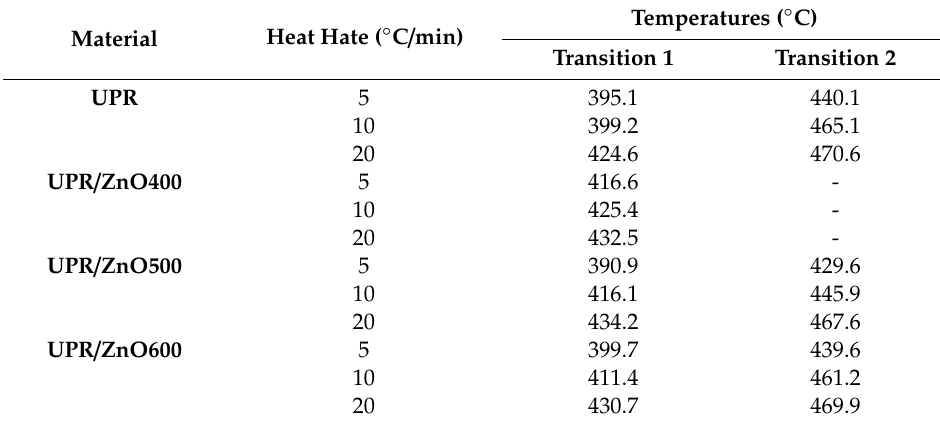
Table 2. Transition temperatures obtained from the DTG curves.